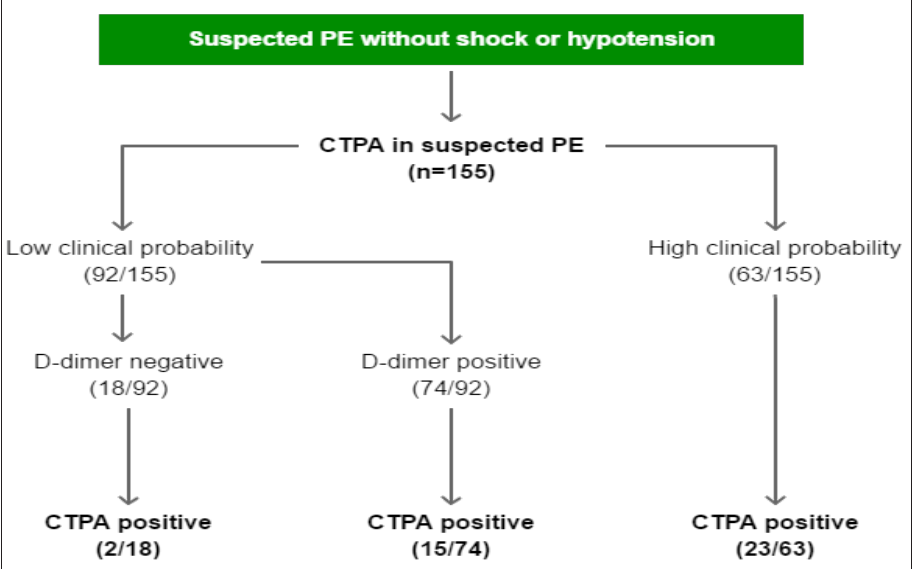
Fig. 1. Simplified overview of the diagnostic algorithm including the CTPA diagnostic yield. PE, pulmonary embolism; CTPA, CT pulmonary angiography. Modified by: Eur Heart J. 2014 Nov 14;35(43):3033-69, 3069a-3069k (ref. 15